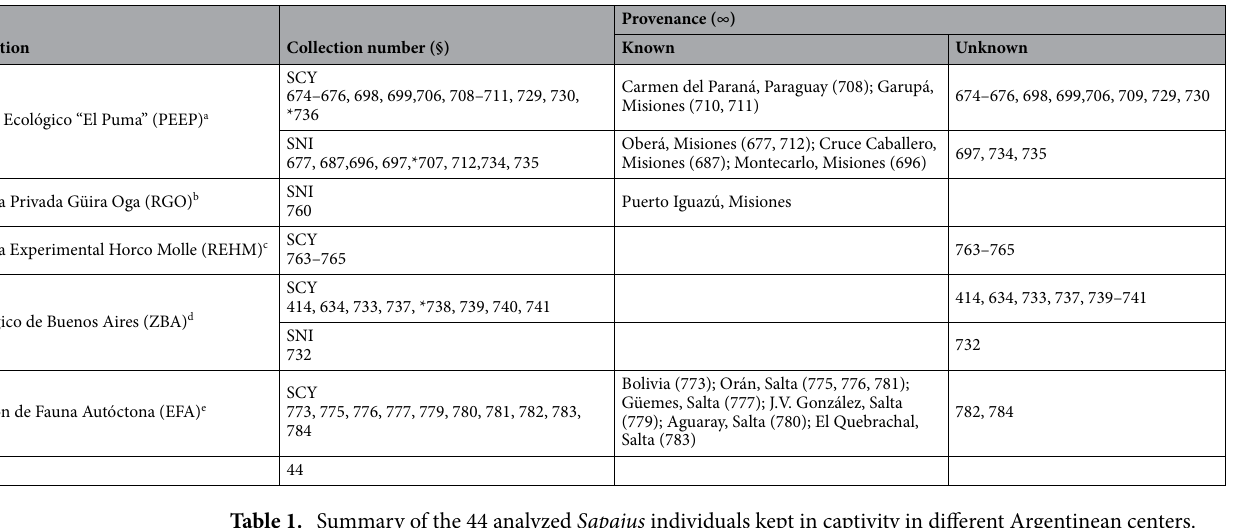
Table 1. Summary of the 44 analyzed Sapajus individuals kept in captivity in different Argentinean centers. a Candelaria, Misiones (27° 27 ′ 39.7 ″ S–55° 44 ′ 38.5 ″ W). b Puerto Iguazú, Misiones (25° 35 ′ 49.1 ″ S–54°34 ′ 43.1 ″ W). c San Miguel de Tucumán, Tucumán (26° 48 ′ 32.1 ″ S–65° 13 ′ 14.8 ″ W). d Ciudad Autónoma de Buenos Aires, Buenos Aires (34° 34 ′ 44.4 ″ S-58° 24 ′ 55.9 ″ W). e Ciudad de Salta, Salta (24° 46 ′ 59.6 ″